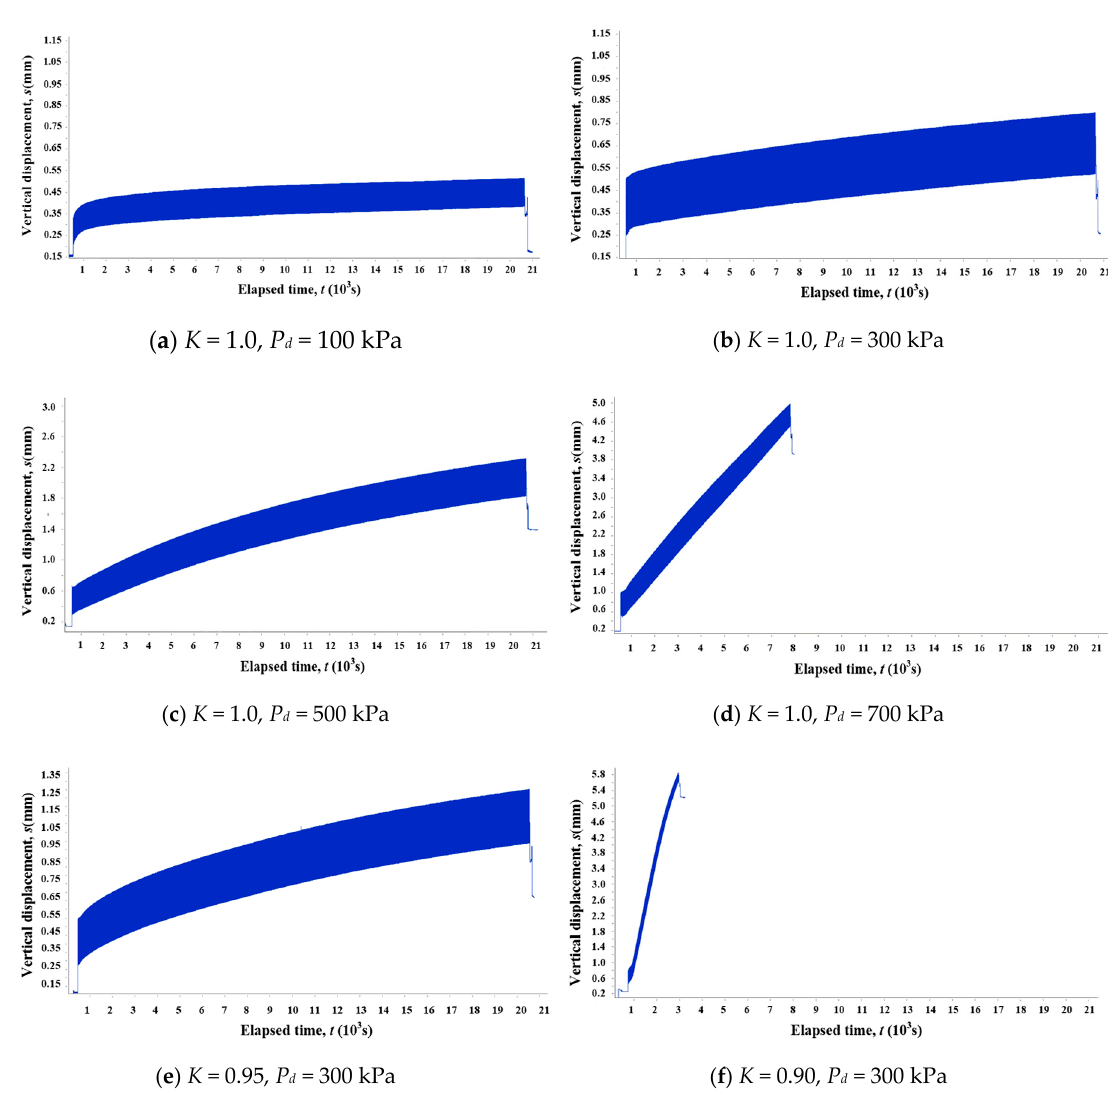
Figure 7. Vertical displacement for the three models under cyclic loading.